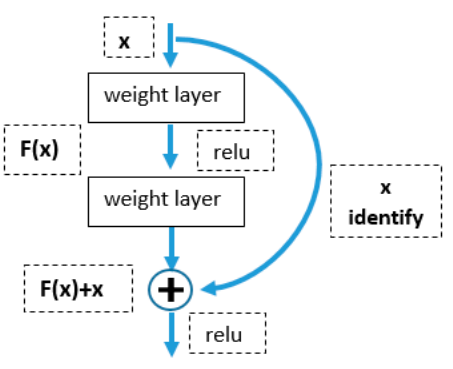
Figure 3. Residual block.